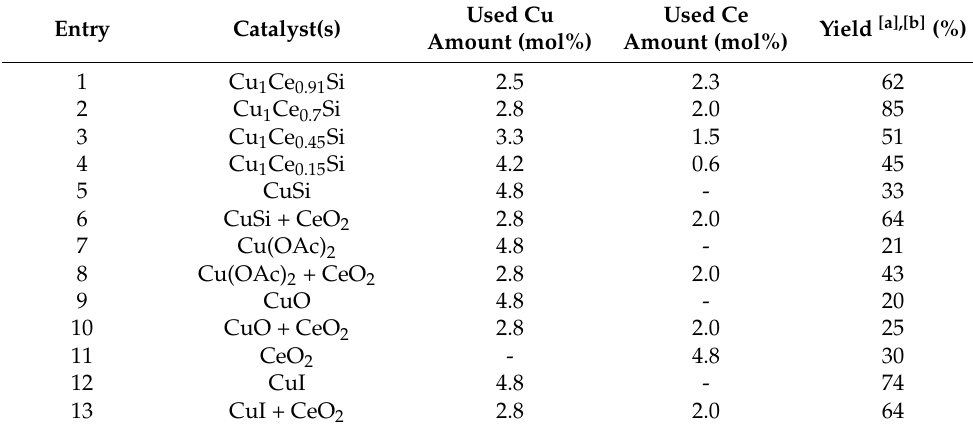
Table 3. Catalytic performance of Cu- and Ce-based catalysts in the cross-dehydrogenative coupling a between THF and 1,1-diphenylethylene.